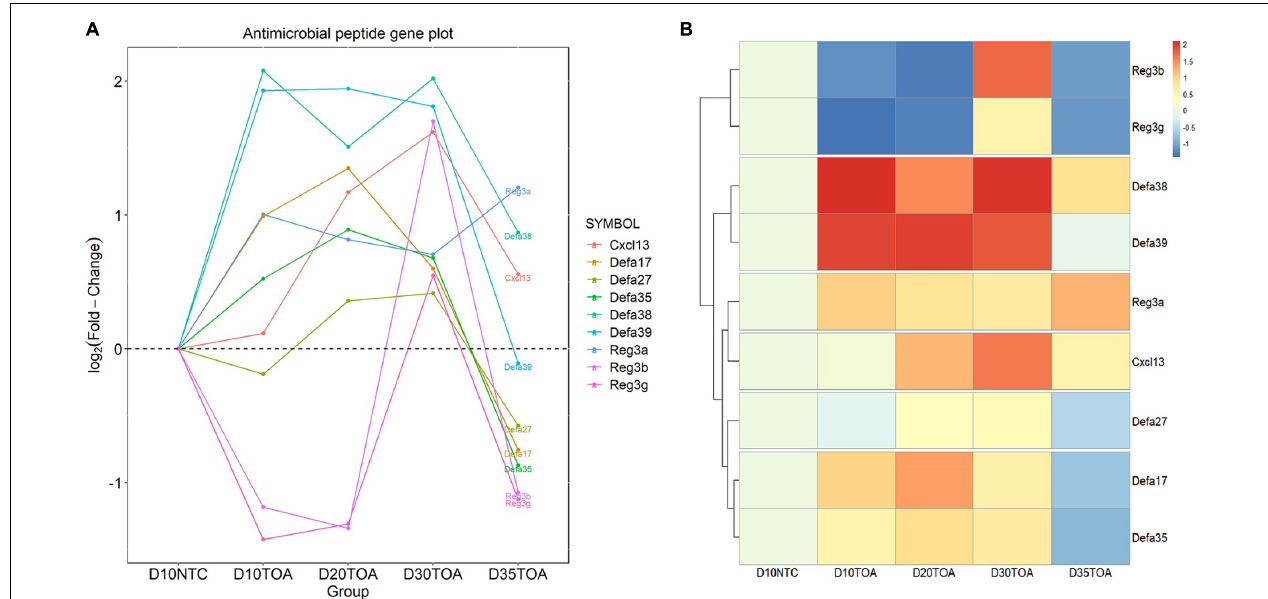
FIGURE 4 | Time Series Analysis of antimicrobial peptide expression. Time trend analysis of antimicrobial peptide expression was followed by the STEM software. Time trend curve was visualized by R software with ggplot2 package (A) , and cluster analysis was visualized by R software with pheatmap package (B)